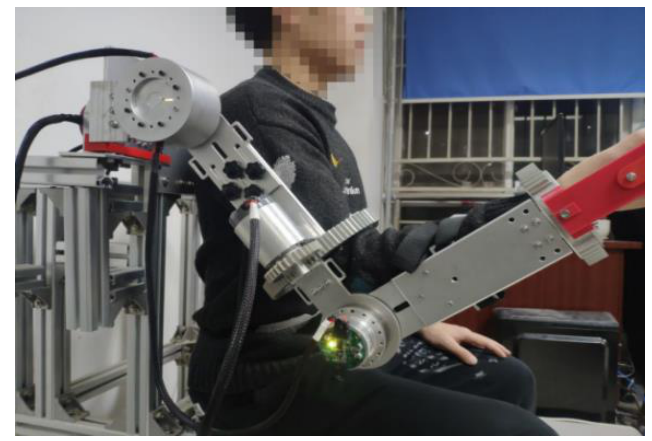
Figure 6. Passive rehabilitation training experiment platform.